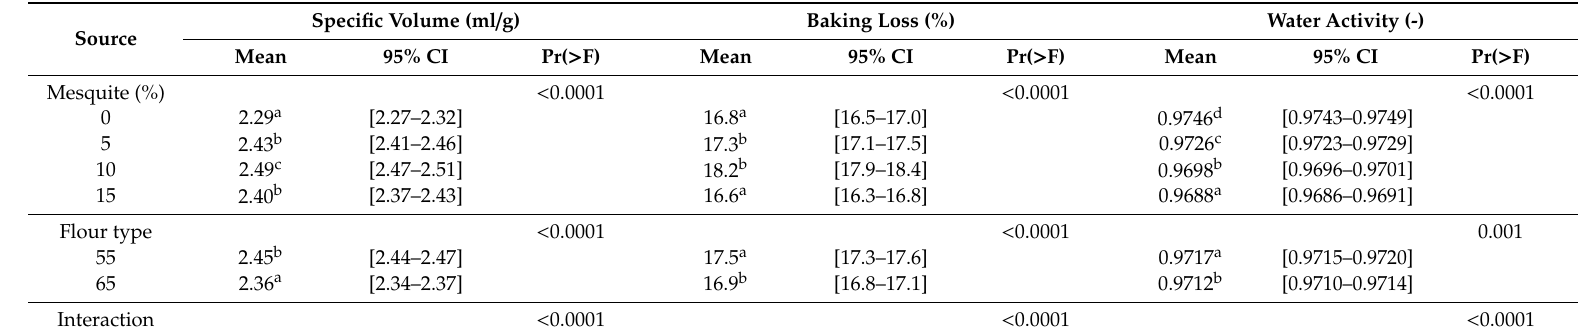
Table A2. Combined e ff ect of mesquite flour substitution level and wheat flour type on physicochemical properties of composite breads, showing means and 95% confidence